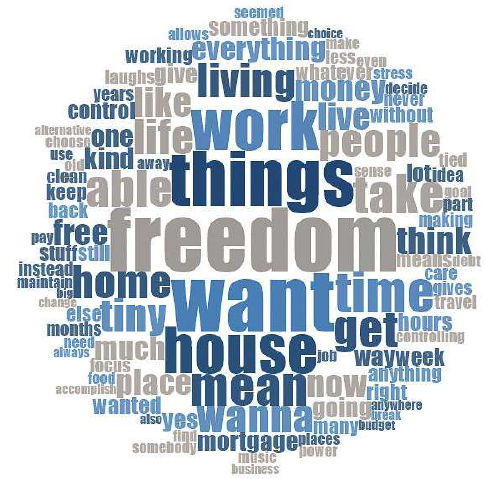
Figure 3. Word cloud for Motivator 2.